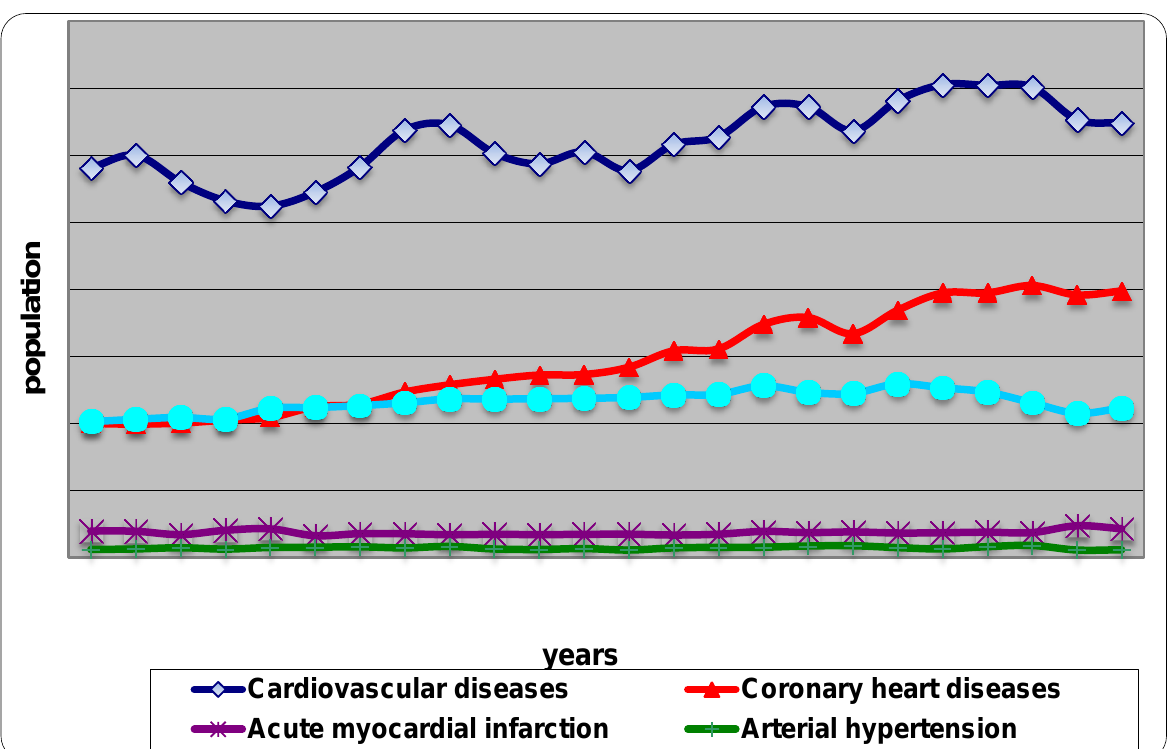
Figure 2: Death rate of the Kyrgyz Republic population from different cardiovascular